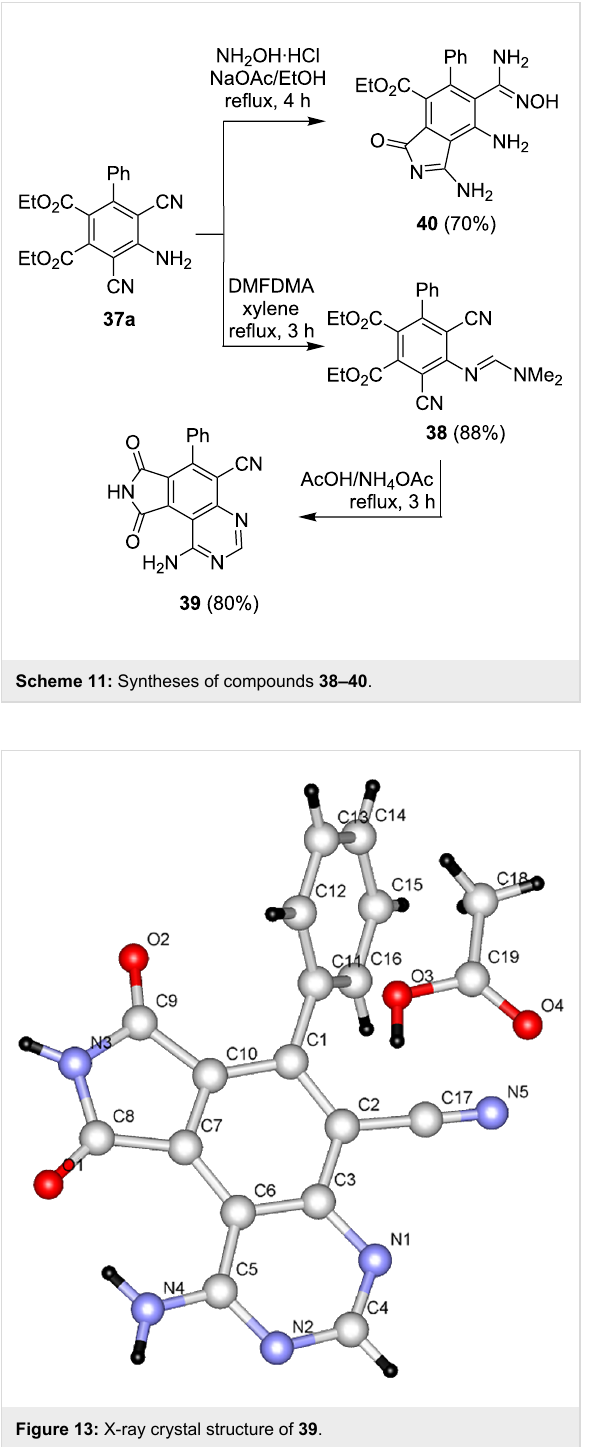
mediates for the synthesis of 6-amino-5-cyanonicotinic acid derivatives 31a , b , ethyl 4-amino-5 H -pyrano[2,3- d ]pyrimidine- 6-carboxylates 33a , b , 4-amino-6 H -pyrrolo[3,4- g ]quinazoline-9- carbonitrile 39 , and 1,7-diamino-6-( N '-hydroxycarbamimidoyl)- 3-oxo-5-phenyl-3 H -isoindole-4-carboxylate 40